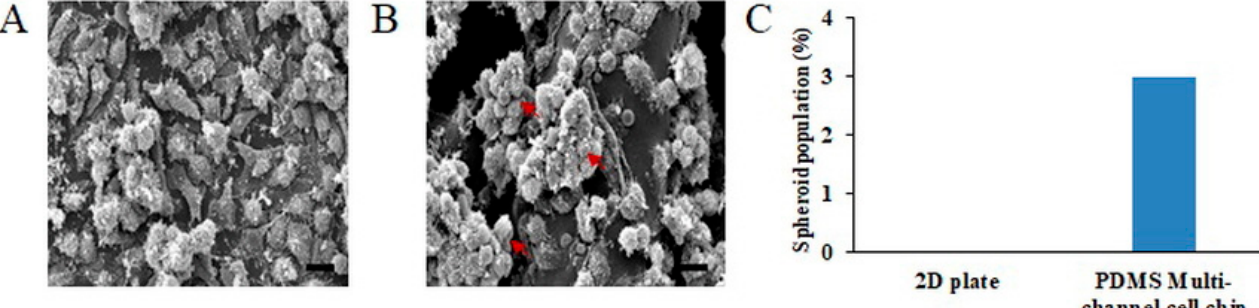
Figure 4. Scanning electron microscope (SEM) images of the comparison of HeLa cell morphology in a two-dimensional (2D) plate ( A ) and, polydimethylsiloxane (PDMS) multi-channel cell chip ( B ) (scale bar: 10 µm). Results of the number of spheroid cells obtained by SEM image ( C ).